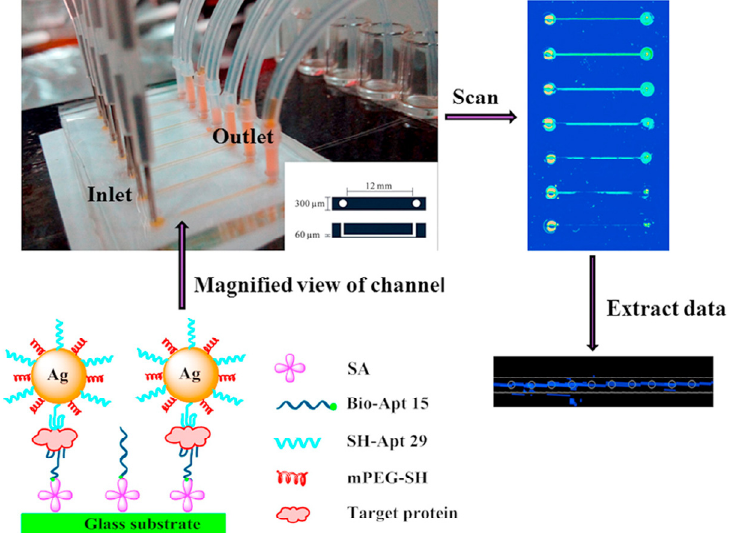
Figure 5. Schematic illustration of the sandwich structure of TBA1, TBA2 and thrombin and the structure of microfluidic chip for thrombin detection. Adapted with permission from Ref. [79]. Copyright (2016), Elsevier.